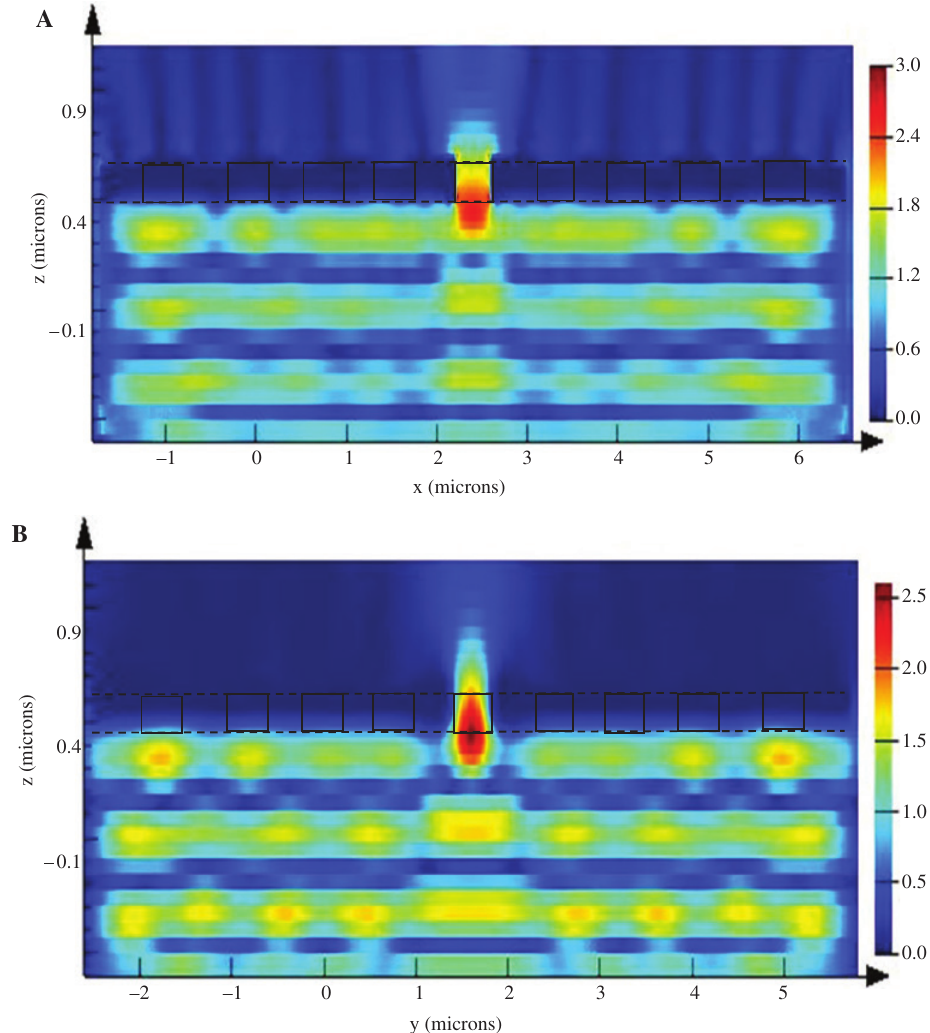
Figure 2: E-field intensity distribution of the metalens in free space. It shows beaming effect of the designed metallic structure at near field for the special case of k respectively.